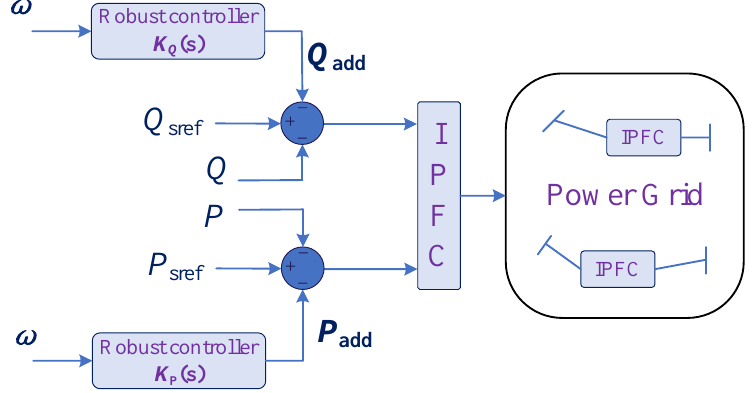
Figure 6. The total robust LFO suppress strategy for IPFC.